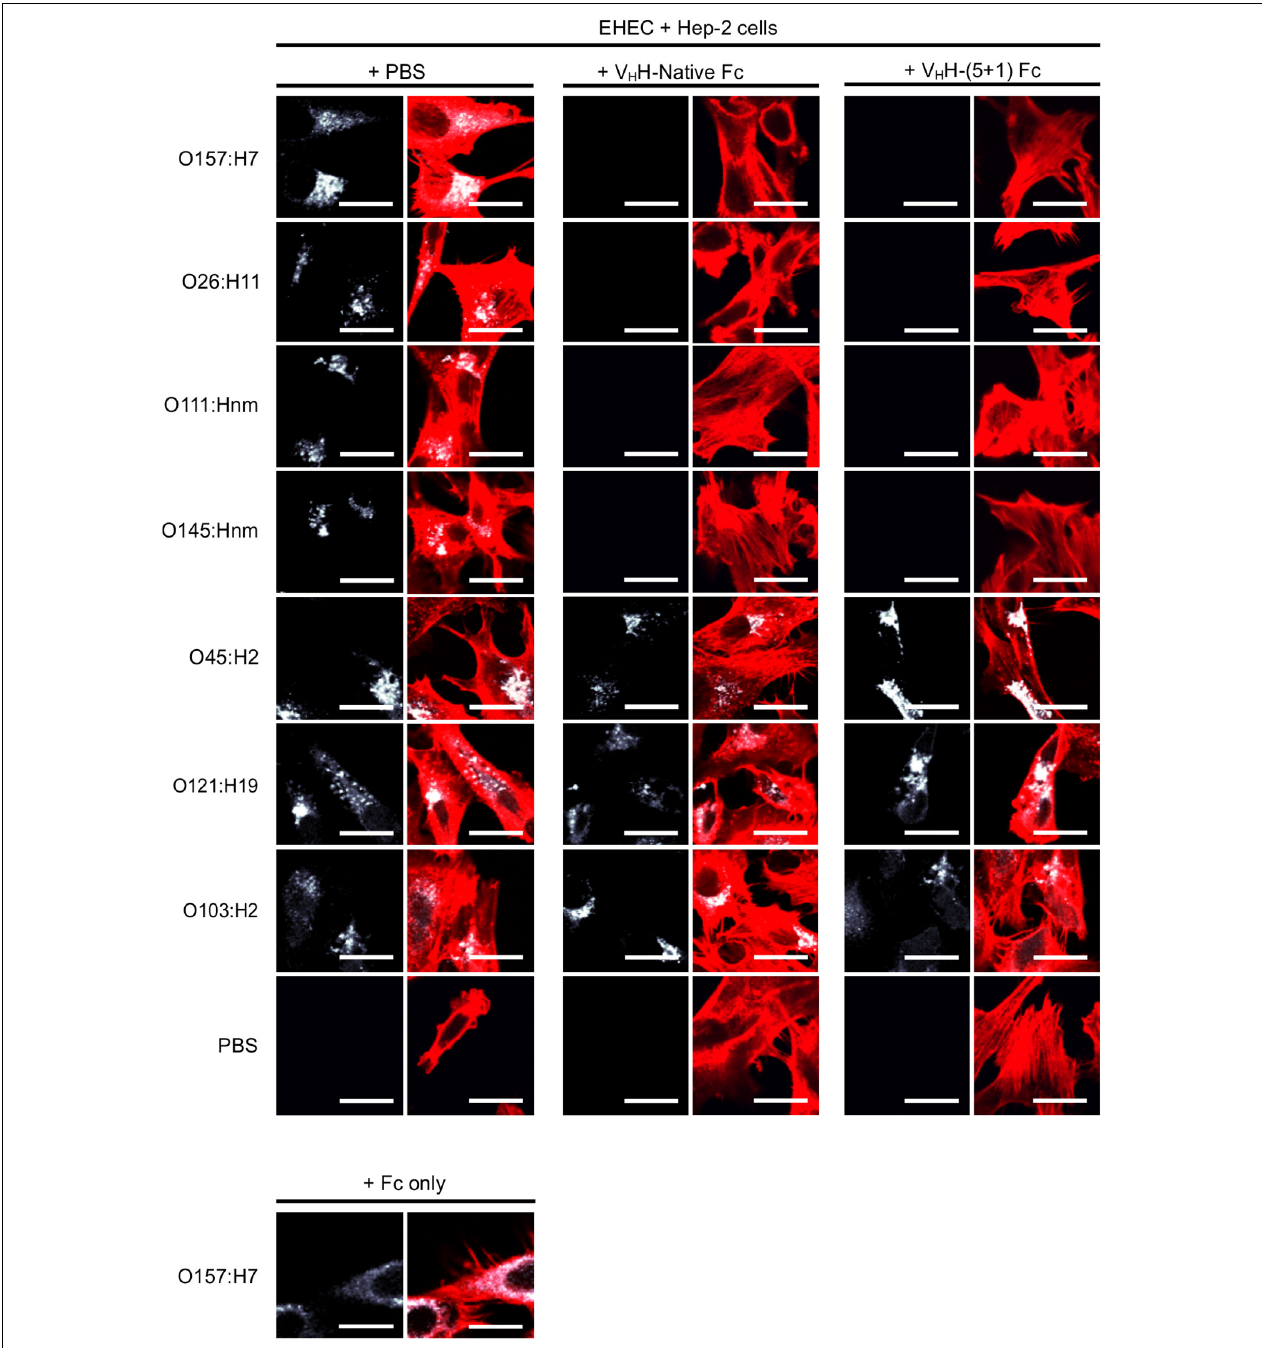
FIGURE 5 | V H H-(5 + 1)Fc retains the V H H-Native Fc’s pattern of cross-serotype protection by neutralizing bacterial levels of O26:H11, O111:Hnm, O145:Hnm and O157:H7. Shown are confocal images of the seven most prevalent EHEC strains (white) that have been incubated with HEp-2 cells (red) in the presence of either 1x PBS as a control, with V H H-Native Fc or with V H H-(5 + 1)Fc. As a control against non-specific Fc binding, O157:H7 was incubated with Fc only to confirm that neutralization was mediated through the V H H. Size bar = 20 µ